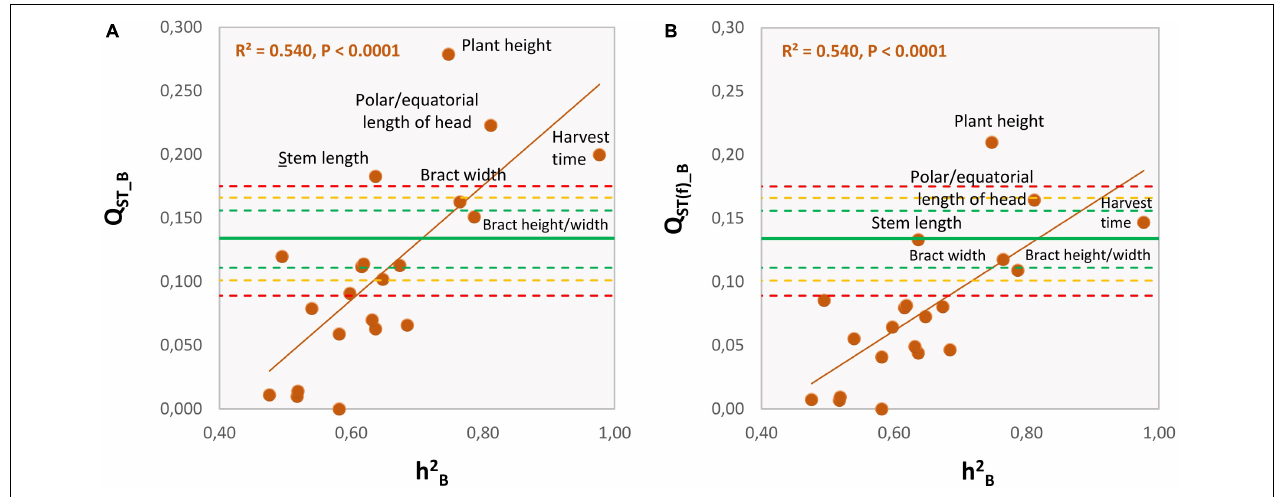
FIGURE 3 | Relationships between the level of quantitative-genetic subdivision among the SSR groups (Q ST_B ) and the average heritability within the SSR groups (h 2 B ) for the 21 phenotypic traits recorded at the harvest of the first head, as listed in Table 3 . Q ST_B was calculated assuming F IS = 0.00 (A) or for the neutral F IS = –0.315 estimated from the SSR data (B) . Orange continuous line, regression line; green continuous line: average level of genetic subdivision among groups (F ST ) based on putatively neutral SSRs; green, yellow, and red dashed lines: lower and upper limits (95%, 99%, 99.9%, respectively) of the neutral F ST based on bootstrap.